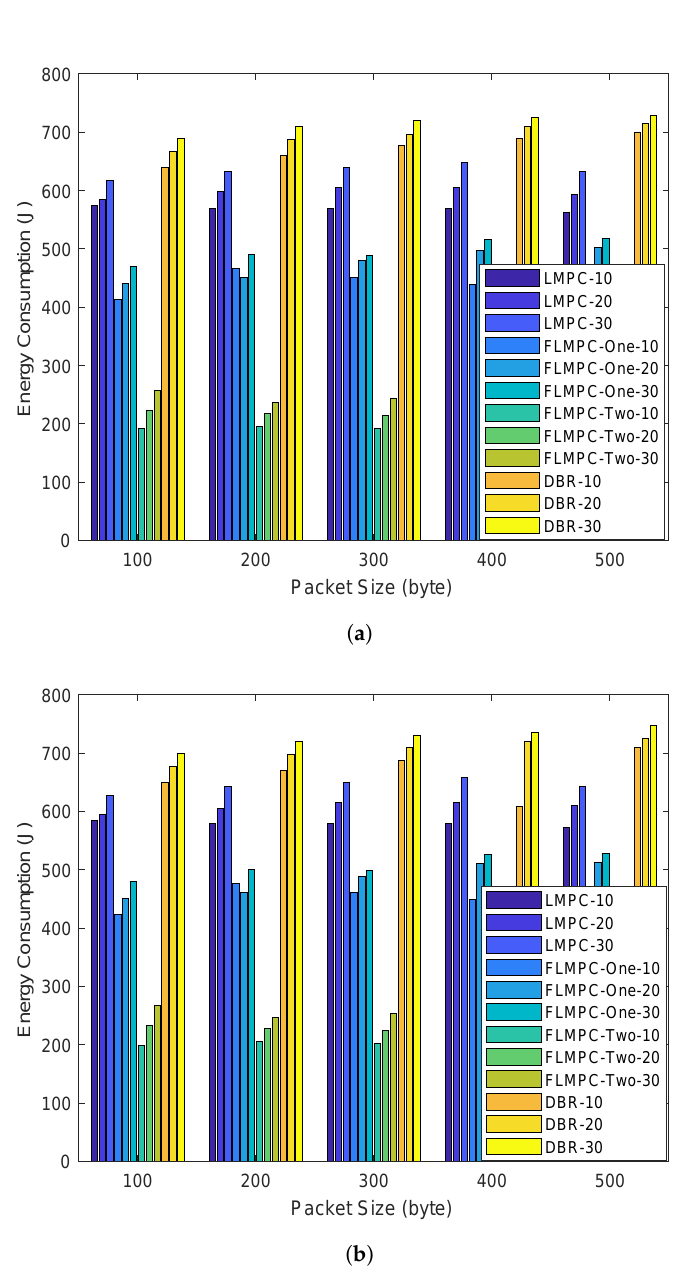
Figure 11. Energy Consumption with Different Data Rate and Packet Size. ( a ) Scenario-1; ( b )